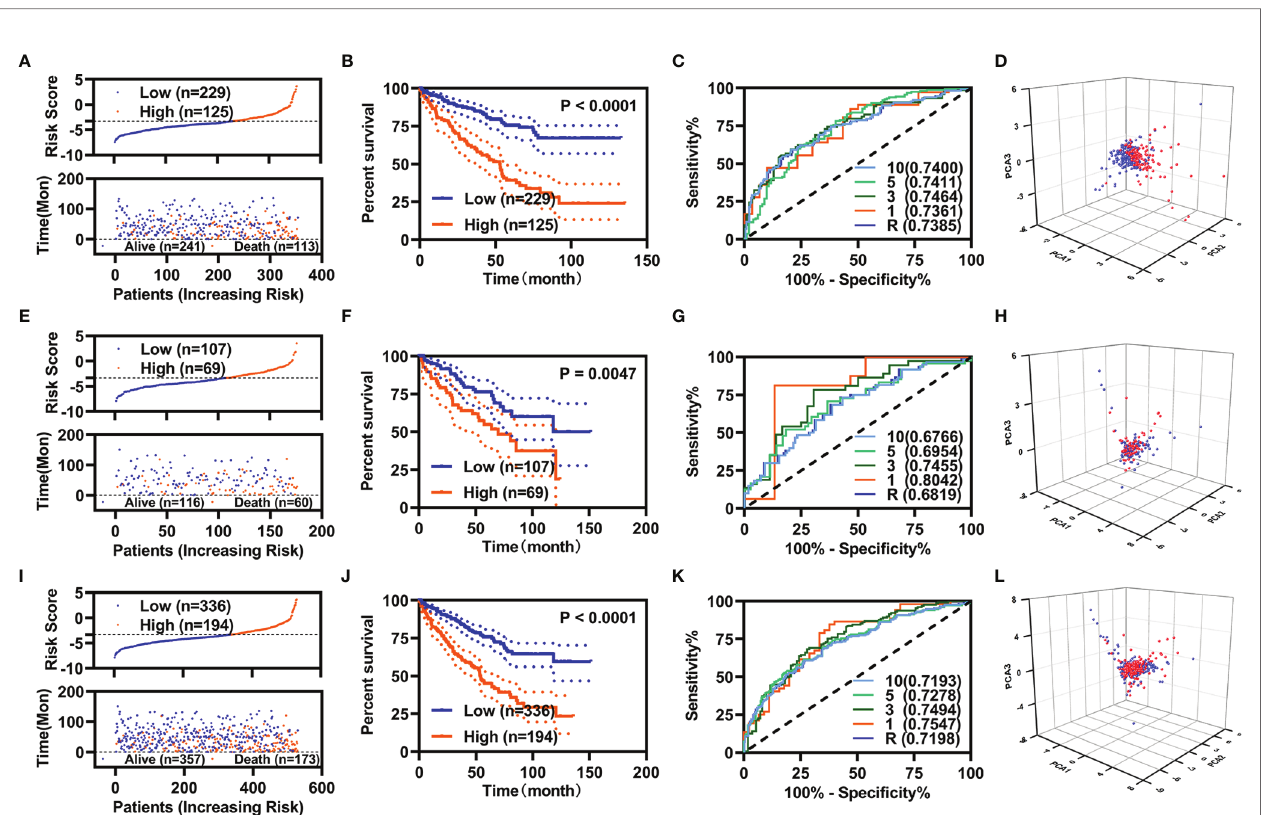
FIGURE 2 | Speci fi c prognostic model constructions. (A – D) For the training cohort. (A) Risk value (up) and survival status (down), (B) KM curve, (C) ROC curve, and (D) PCA analyses. (E – H) For the validation cohort. (E) Risk value (up) and survival status (down), (F) KM curve, (G) ROC curve, and (H) PCA analyses. (I – L) For the entire cohort. (I) Risk value (up) and survival status (down), (J) KM curve, (K) ROC curve, and (L) PCA